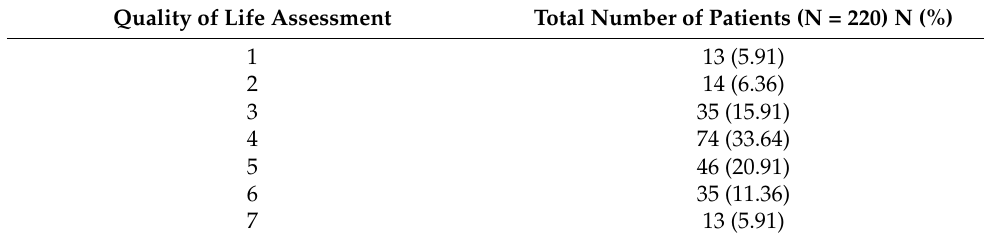
Table 1. Quality of life assessment made by the patients (N =